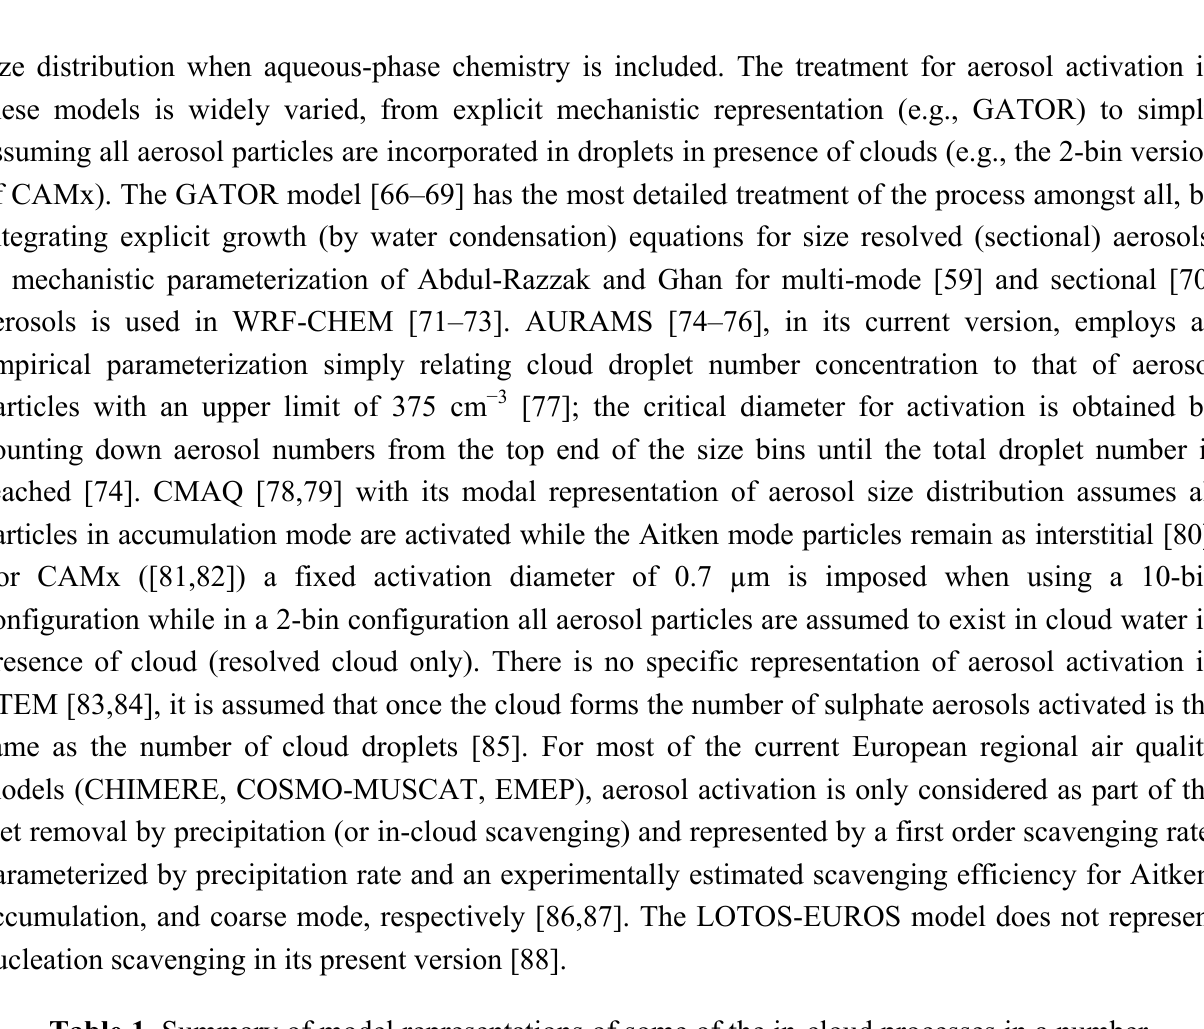
Table 1. Summary of model representations of some of the in-cloud processes in a number of current regional air quality models in North America and